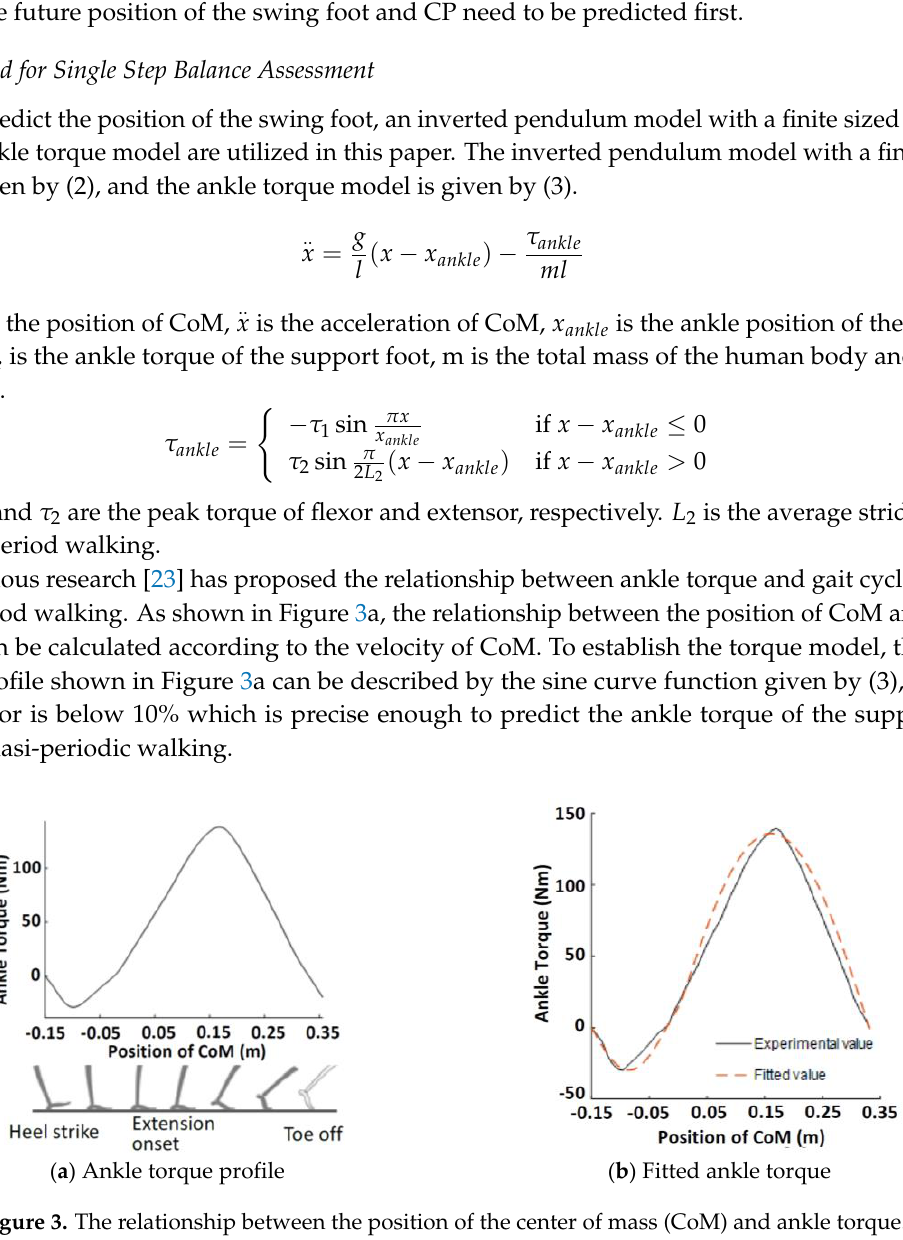
. x ]) can be predicted. In order to verify